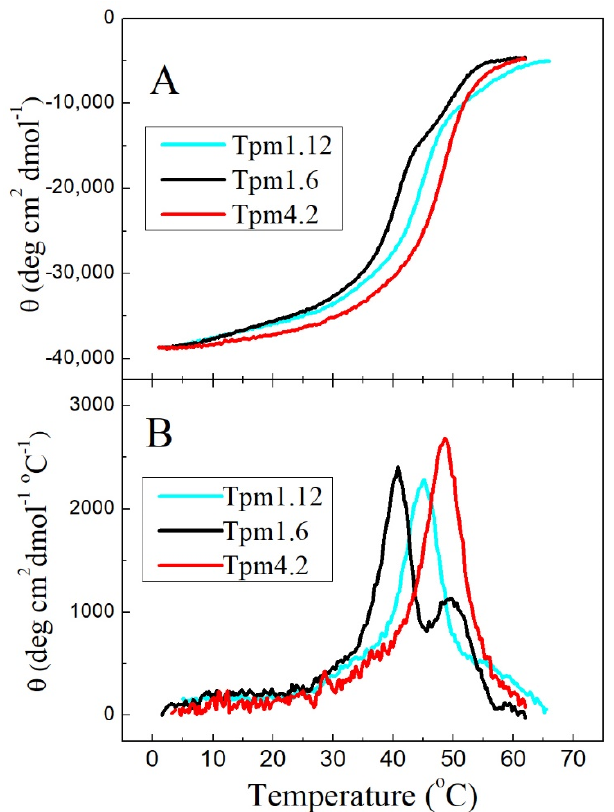
Figure 2. Thermal unfolding of Tpm isoforms Tpm1.6, Tpm1.12, and Tpm4.2 measured by CD. ( A ) Temperature dependences of α -helix stability measured at 222 nm. ( B ) First derivative profiles for data shown in ( A ). All experiments were done at the constant heating rate of 1 ◦ C/min with a protein concentration 1